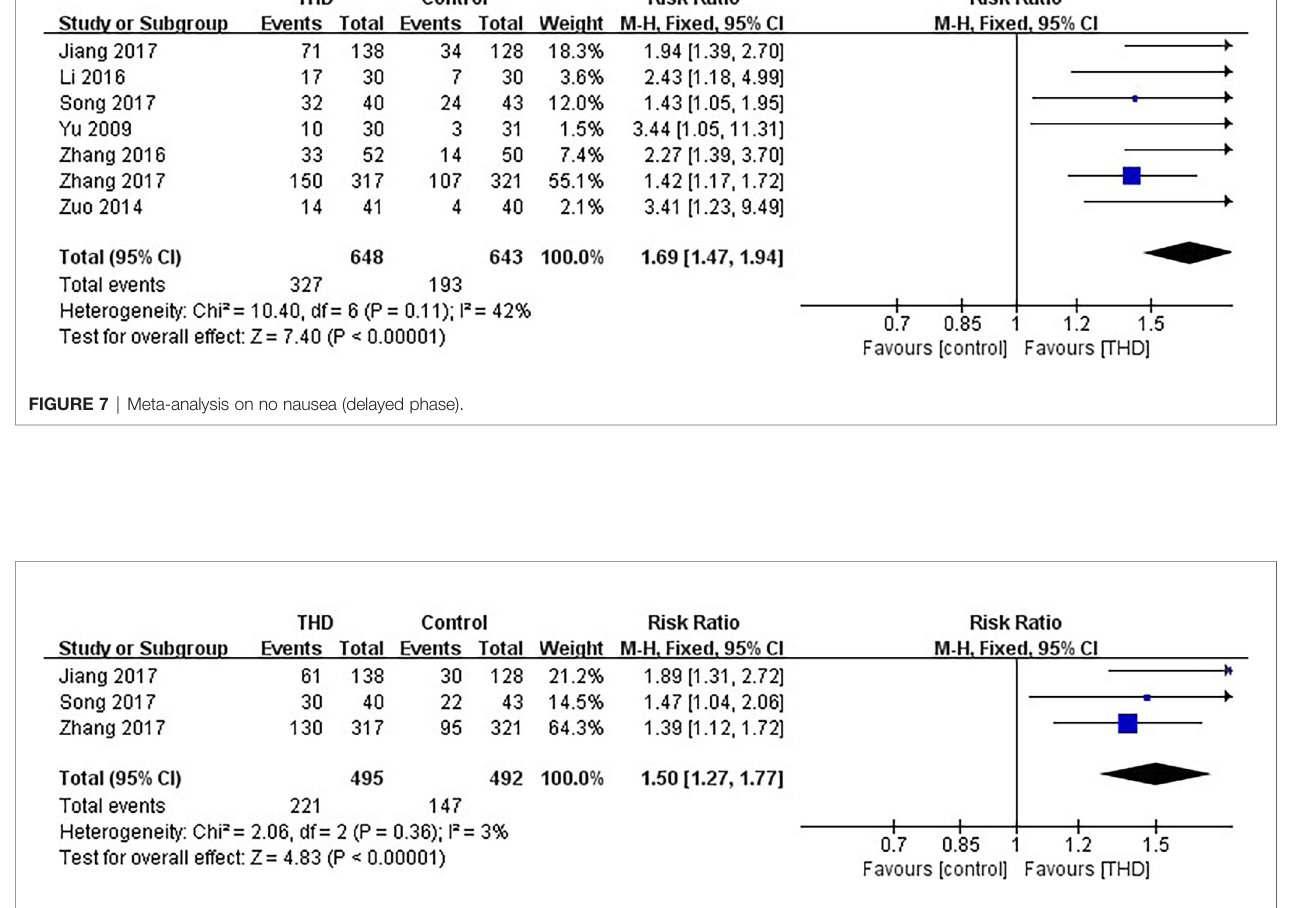
FIGURE 8 | Meta-analysis on no nausea (overall